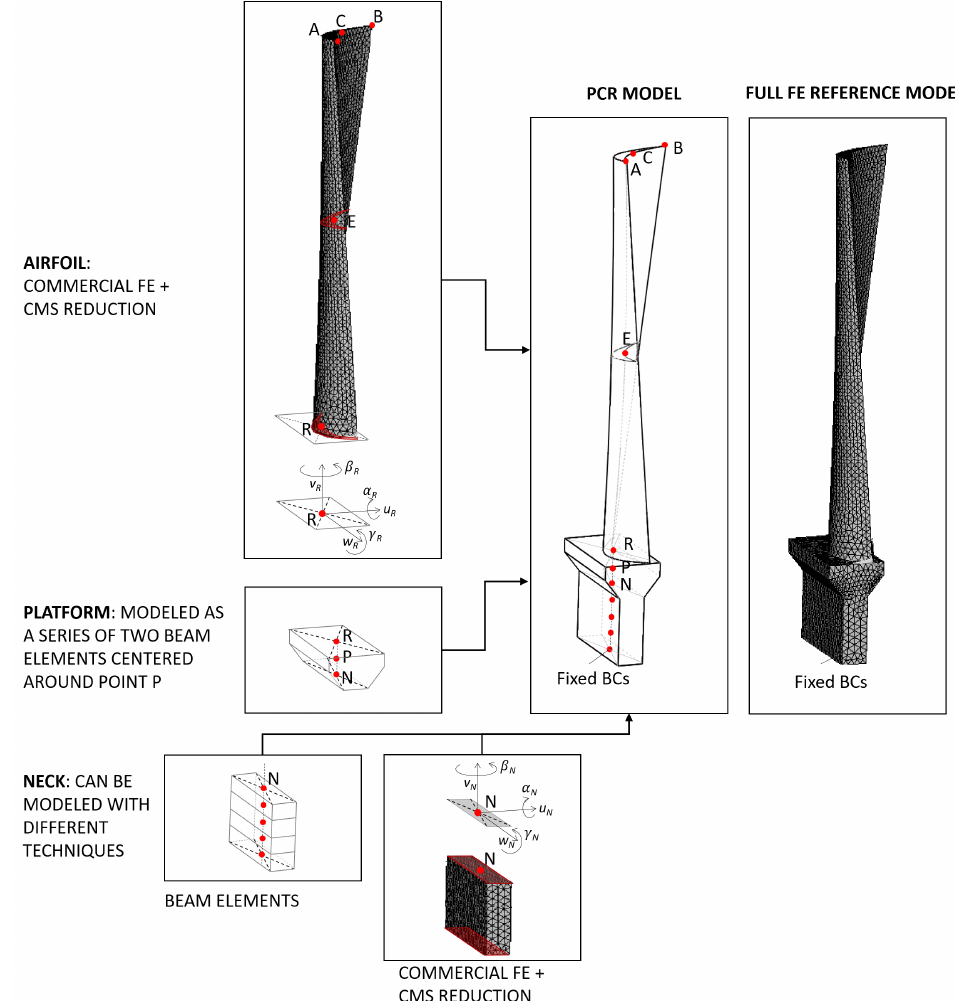
Figure 2. (Left) Assembling procedure to build the PCR model. (Right) Full FE (ANSYS) model: used for tuning the PCR model and for a final linearized response check. Fixed boundary conditions are applied at the connecting end of both